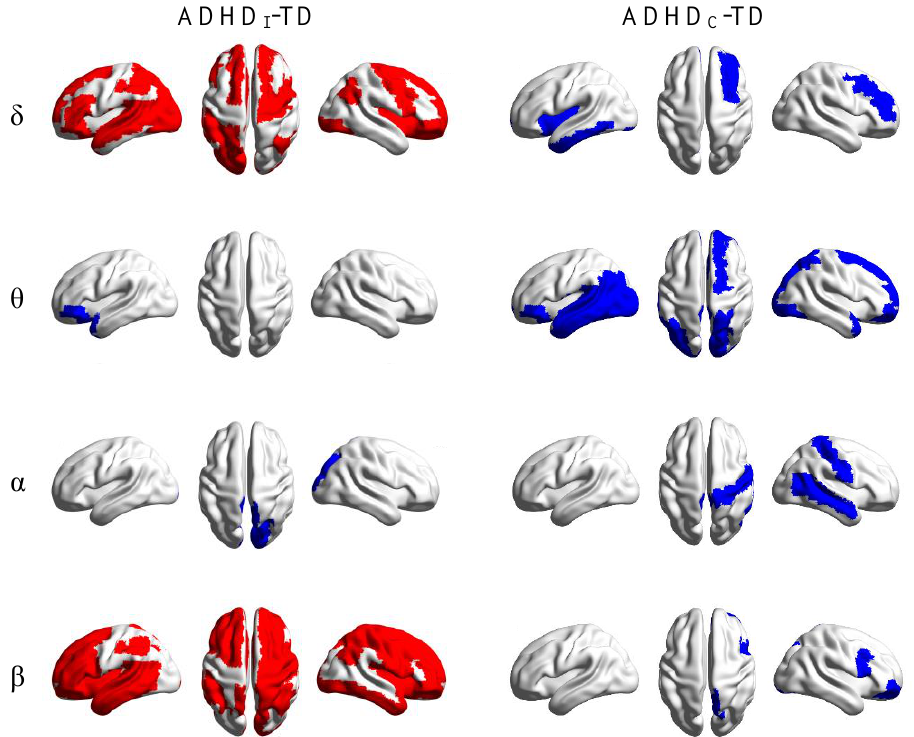
Figure 3. Statistical t-maps of significant differences ( p < 0.05) in the average LPS strengths between the ADHD and TD groups in different frequency bands. Blue and red colors show significant increases and decreases in the average LPS in the ADHD I and ADHD C groups compared with TD individuals, respectively.